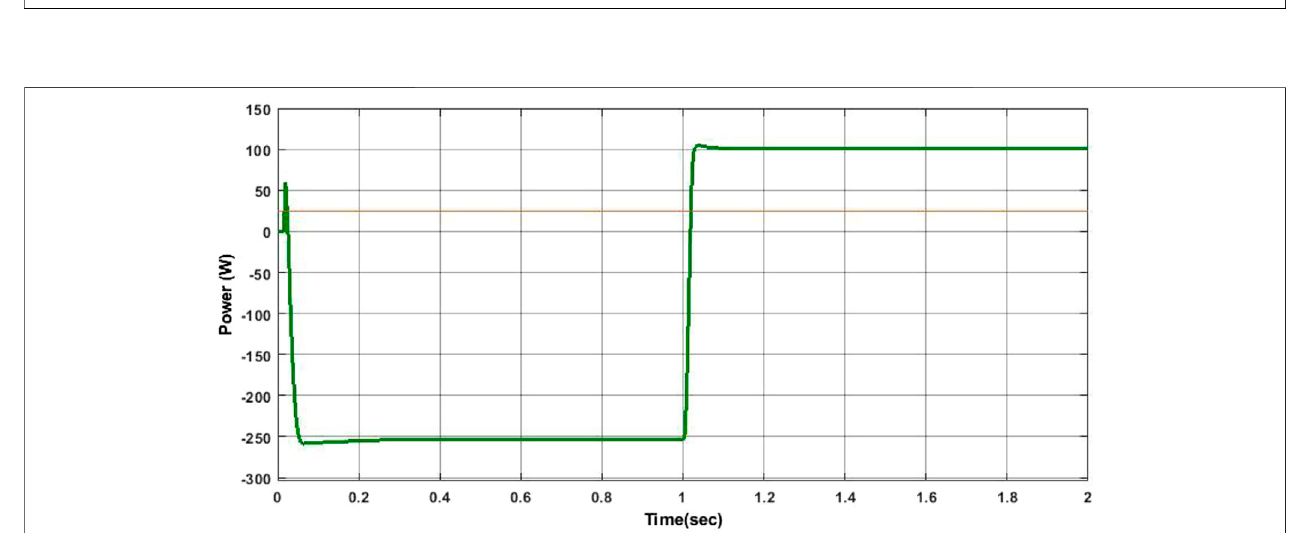
FIGURE 6 | PV output power throughout a day.